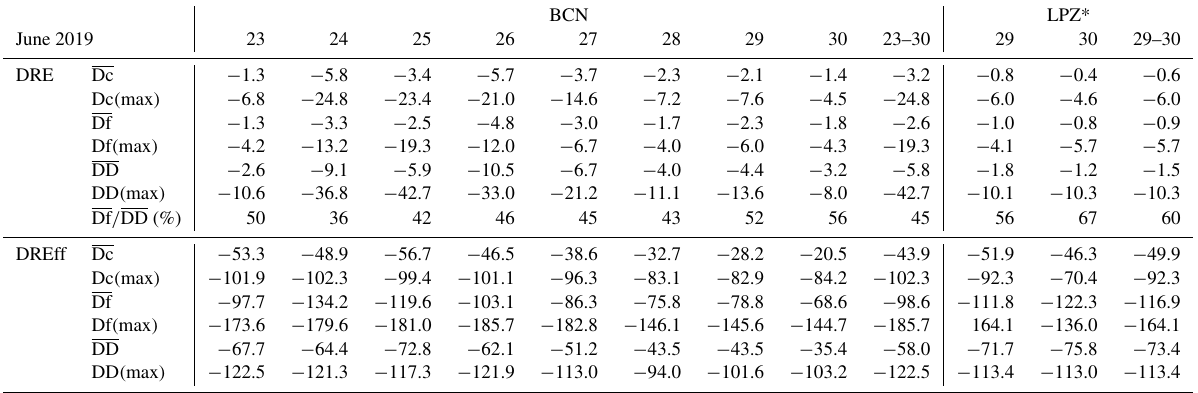
Table 5. Same as Table 4 but at the TOA. DOD 532 values are shown in Table